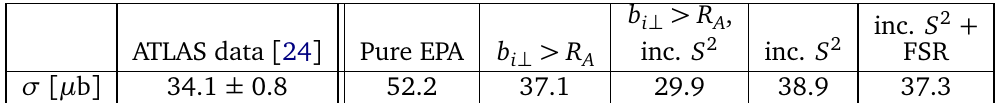
Table 1: Comparison of predictions for exclusive dimuon production in ultraperiph- eral PbPb collisions, with the ATLAS data [ 24 ] at µ > 4 GeV, | η µ | < 2.4, m required to have p ⊥ uncertainties correspond to the sum in quadrature of the statistical and